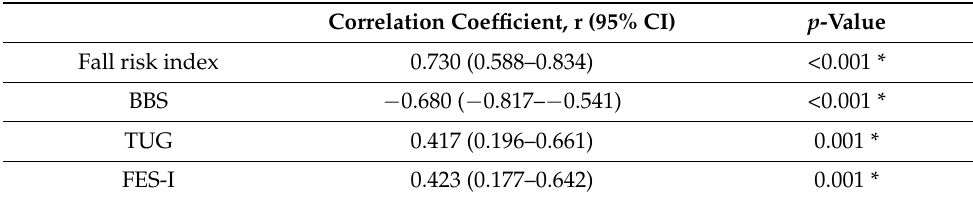
Table 5. Correlations between VPT and postural steadiness, functional balance, and fear of falling in patients with type 2 DM.